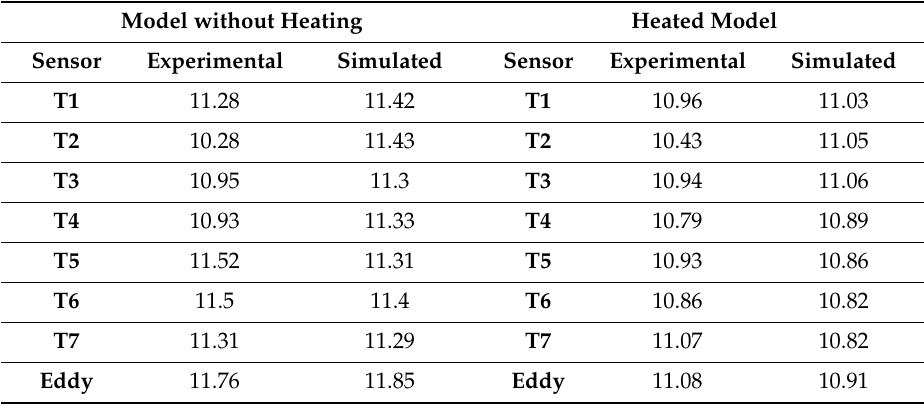
Table 5. Temperature data ( ◦ C) of the evaluated models.